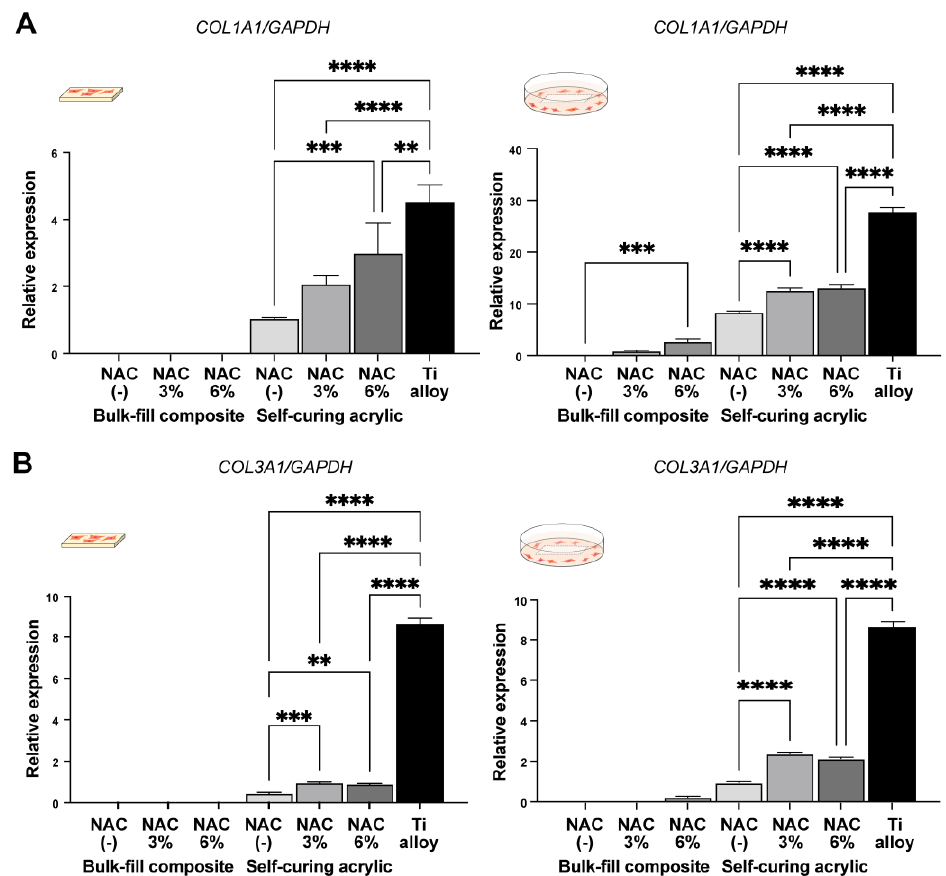
Figure 6. NAC-mediated improvements in material biocompatibility. Real-time PCR for collagen type 1 ( A ) and 3 ( B ) genes conducted on day four are shown. RNA was extracted from contact and proximity experiments: ** p < 0.01, *** p < 0.001, **** p < 0.0001.